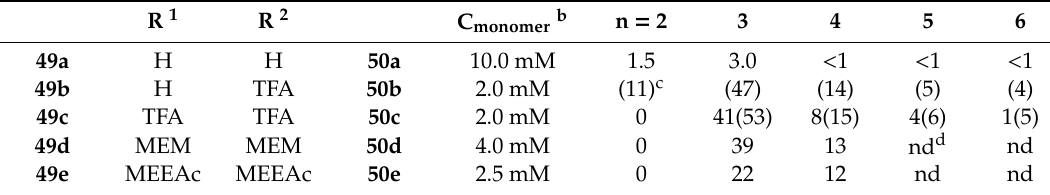
Table 1. Yields of functionalized cyclocholates 50a-e (n = ring size) a